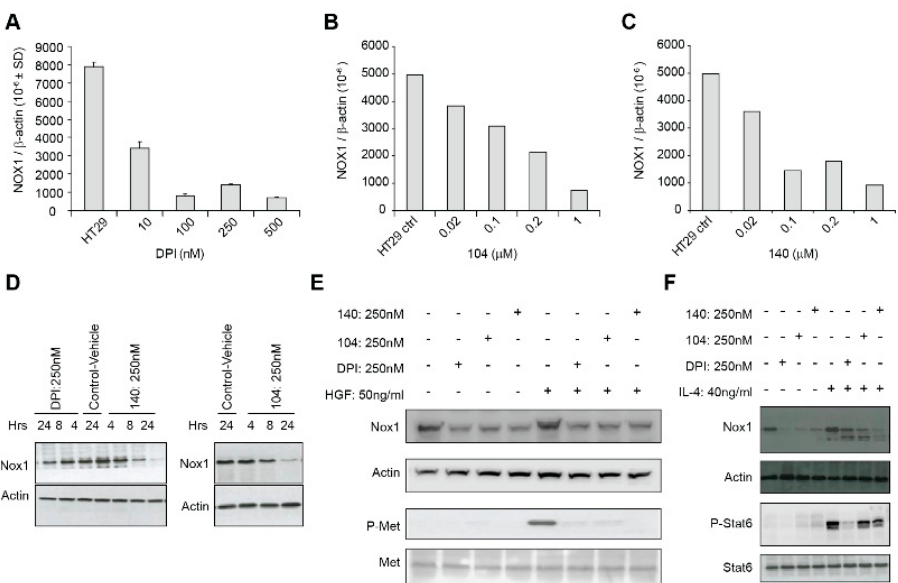
Figure 5. NOX1 expression and c-Met phosphorylation are decreased by io-donium analogs. Concentration-dependent inhibition of NOX1 mRNA ex-pression in HT-29 cells is shown for a 24 h exposure to DPI ( A ), a 24 h exposure to NSC 740104 ( B ), and a 6 h treatment with NSC 751140 ( C ). Decreased NOX1 expression at the protein level is demonstrated following treatment of HT-29 cells with DPI (250 nM), NSC 751140 (250 nM), or NSC 740104 (250 nM) for the time periods shown ( D ). Treatment of HT-29 cells with 250 nm DPI, 104 or 140 for 24 h blocked HGF-induced c-Met